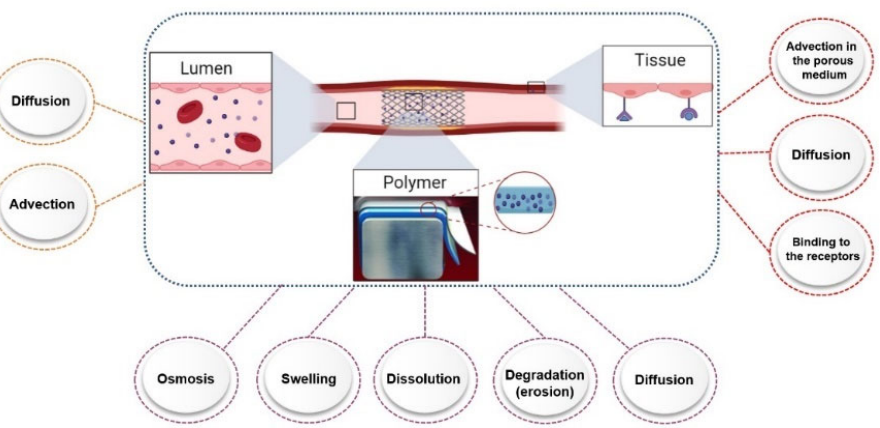
Figure 6. Contribution of different mechanisms at different compartments, affecting the drug release from DES.